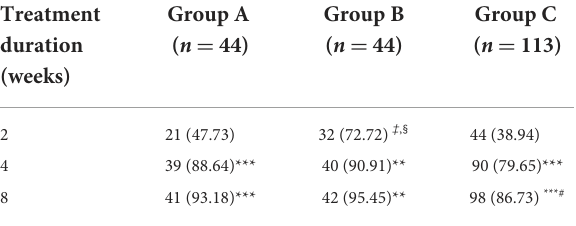
Group A: flupentixol and melitracen + nizatidine; Group B: flupentixol and melitracen + rabeprazole; Group C: flupentixol and melitracen. ‡ P < 0.05: vs. group A at 2 weeks of treatment, § P < 0.05: vs. group C at 2 weeks of treatment. ** P < 0.01, *** P < 0.001: vs. 2 weeks of treatment in the same group. # P < 0.05: vs. 4 weeks of treatment in